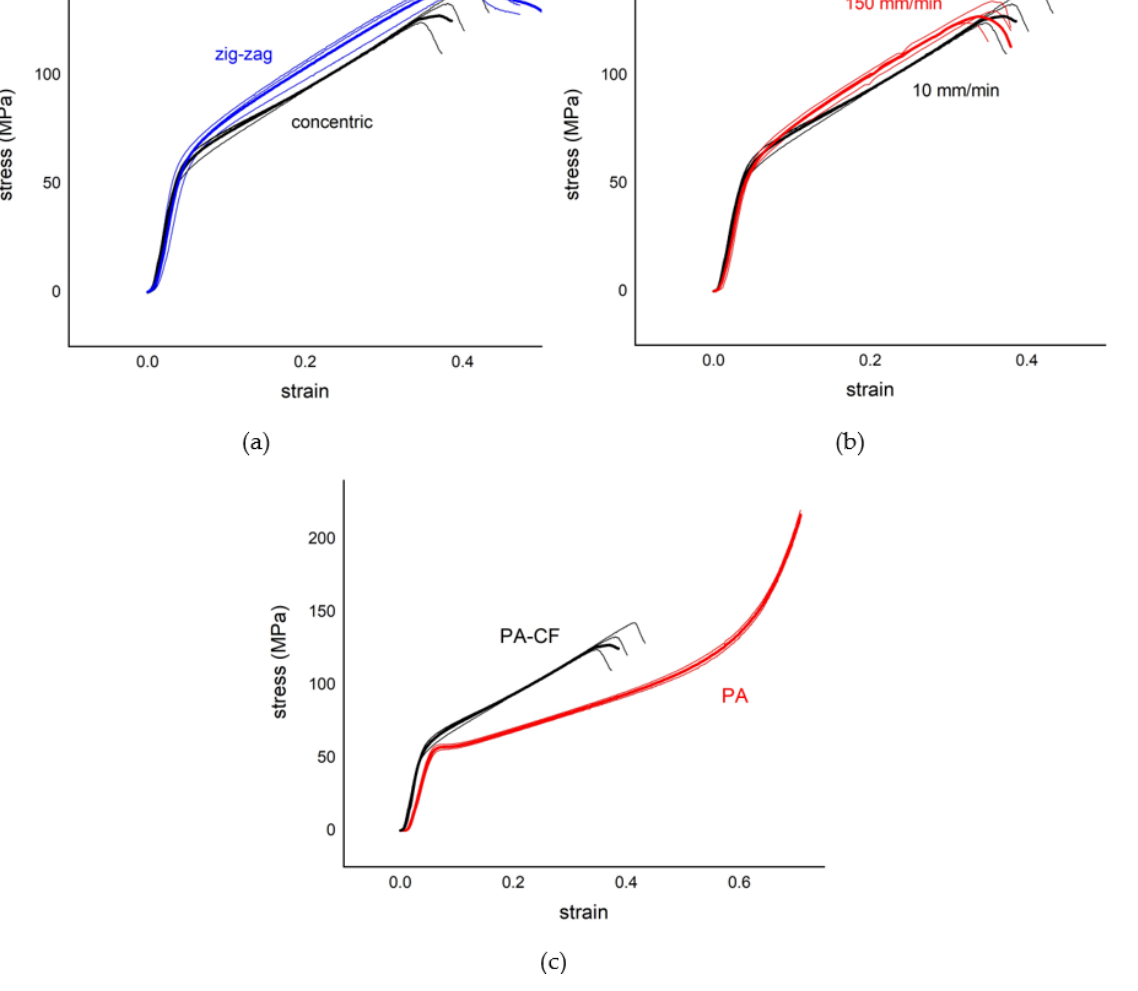
Figure 7. Engineering stress – strain curves obtained by the compression tests of PA – CF effect on ( a ) the printing pattern, ( b ) the compression loading rate, and ( c ) the comparison of PA – CF and PA (thin curves are individual tests whereas bold ones are the averaged curves).